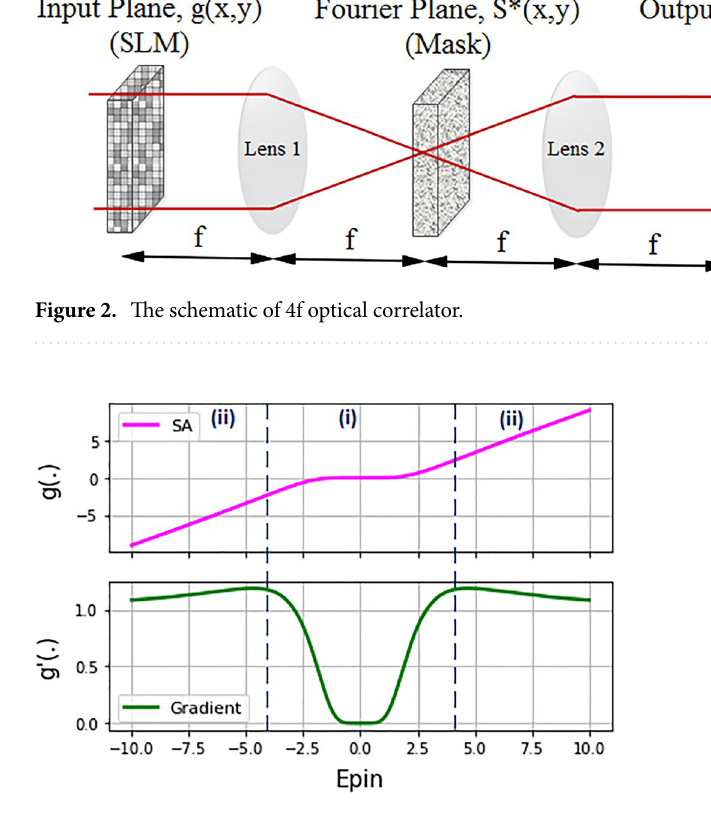
Figure 3. The schematic of SA